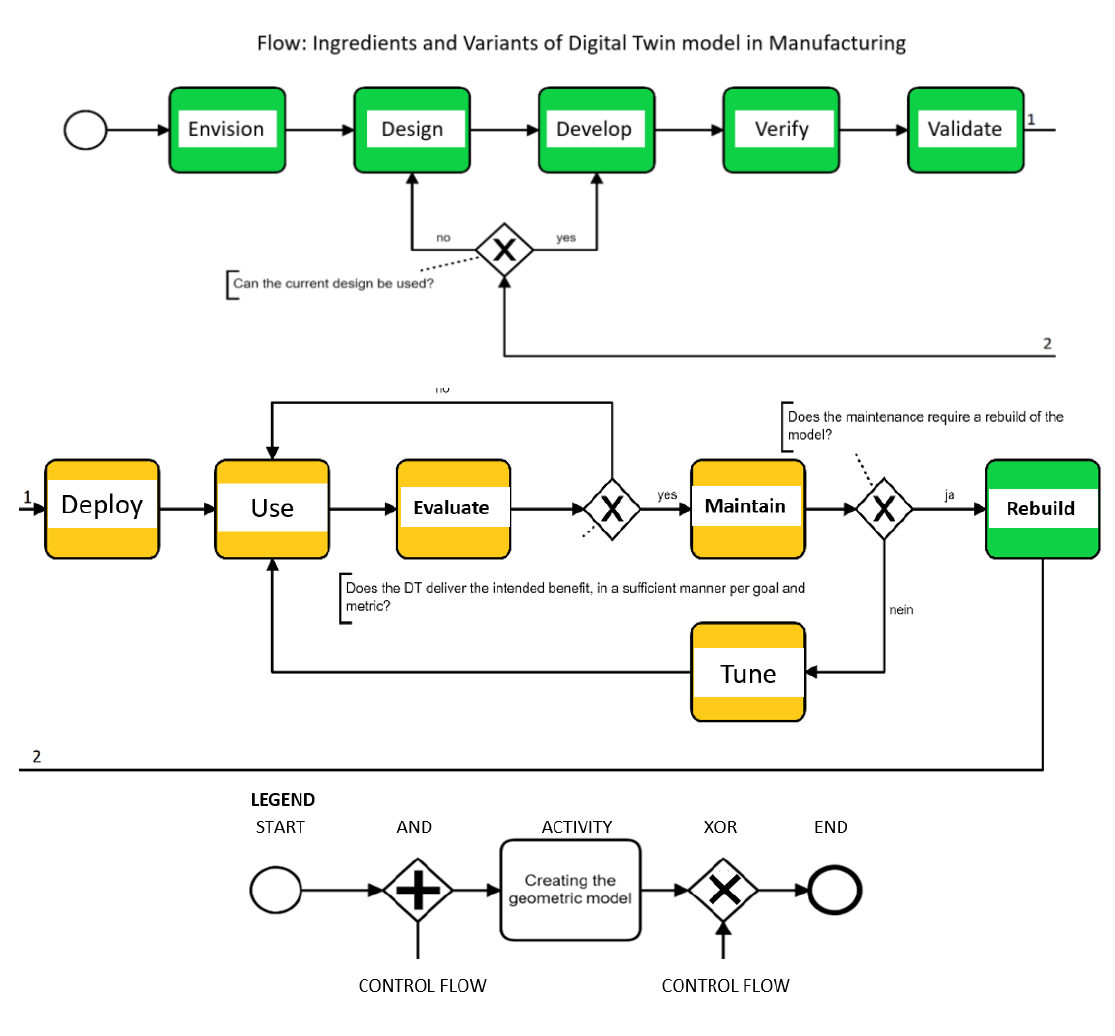
Figure 7. Sequence of steps for DT development model derived from [11] Green: off-line, yellow: on-line activity.